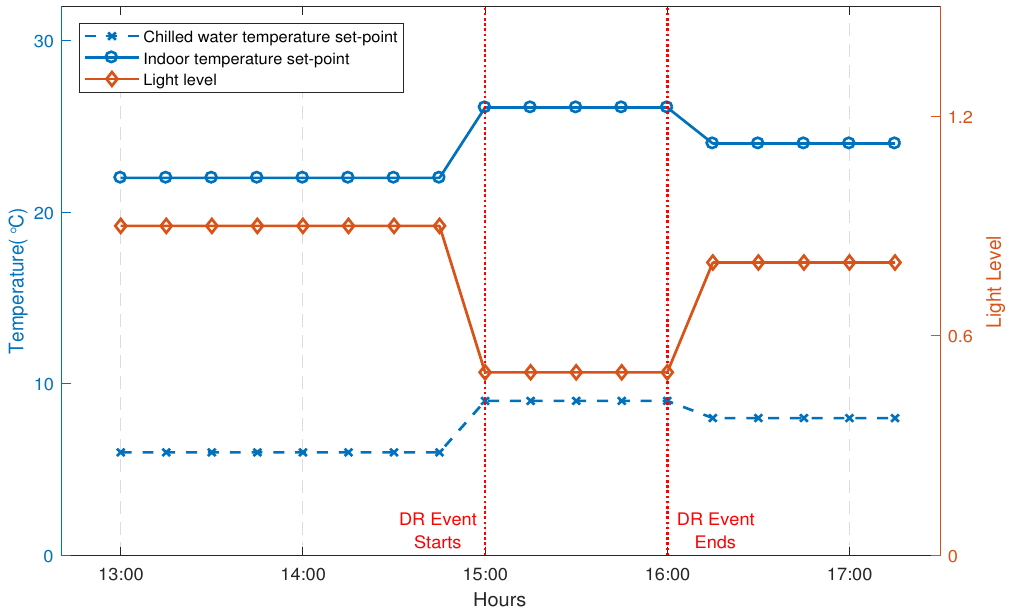
Figure 7. Optimal DR strategy as determined by the MBCRF